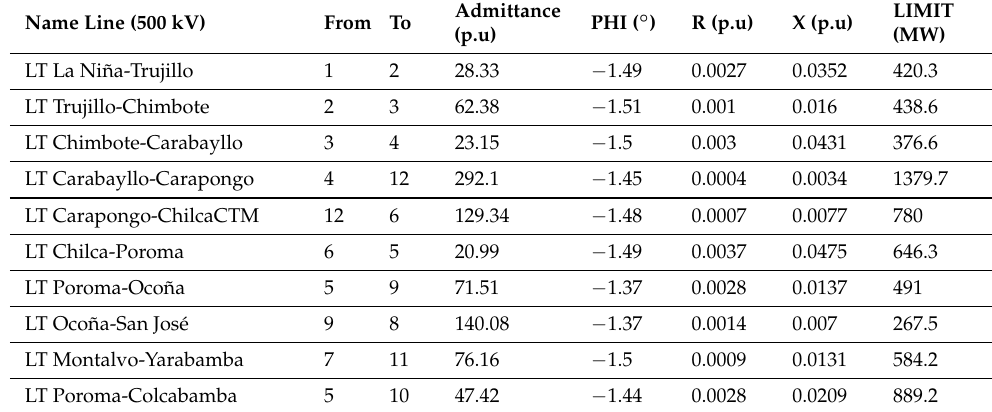
Table 1. Transmission line data of the reduced equivalent model in 500 kV (12-bus) of the SEIN .